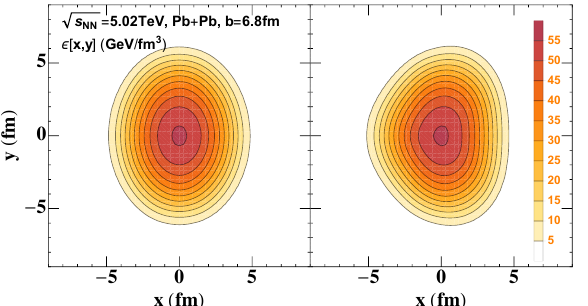
√ s NN = 5.02 TeV Pb-Pb collisions. In